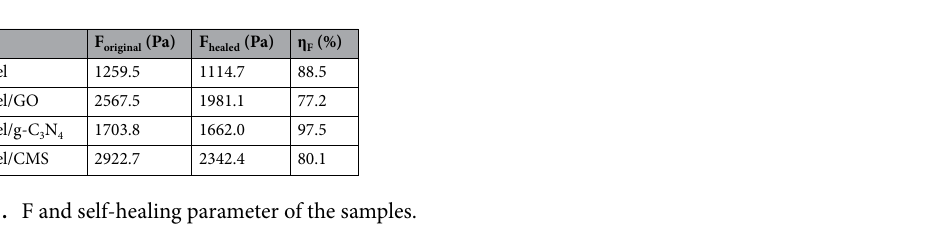
Figure 5. Self-healing procedure ( a ) and stress–strain curve ( b ) of the hydrogels.